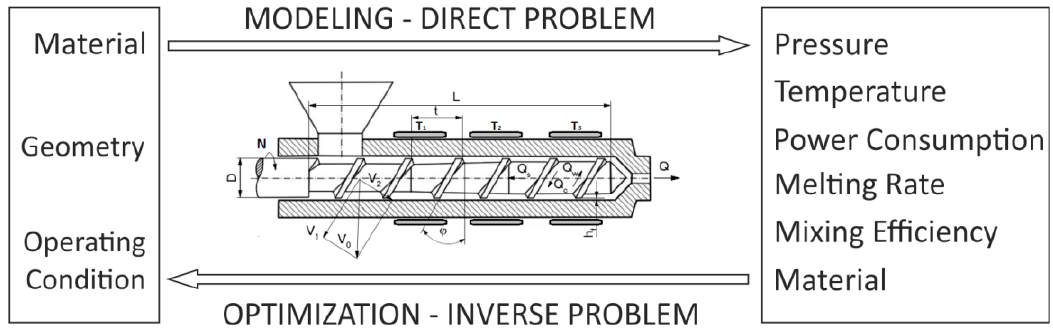
Figure 1. Direct (modeling) and inverse (optimization) problem for polymer extrusion: L, D, t, φ , h—screw geometry parameters, N—screw speed, Q—flow rate, T—temperature conditions, V—velocity.